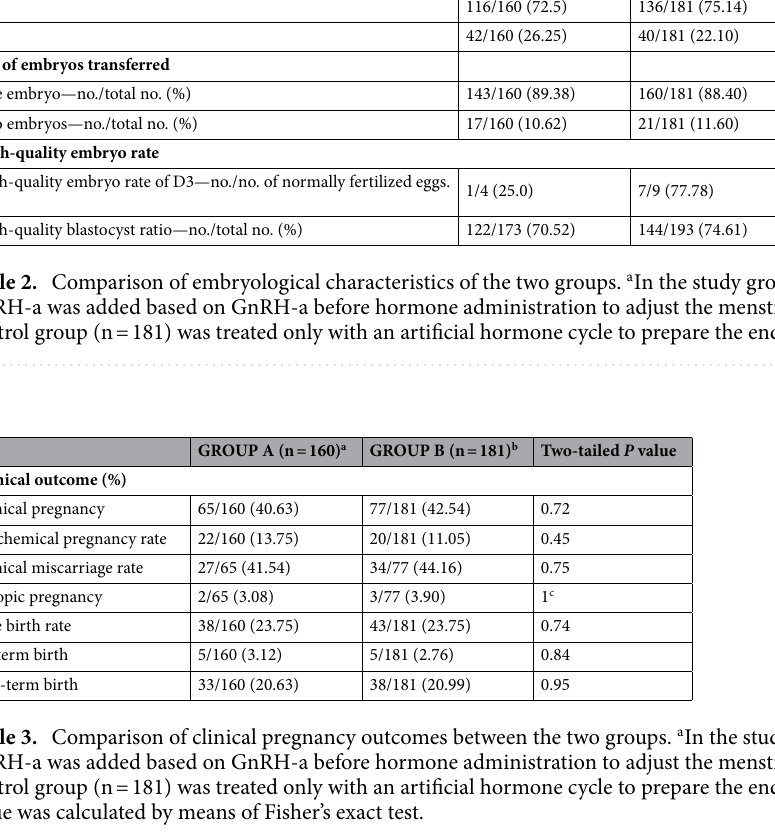
time of embryo transfer and the number of transferred embryos did not differ obviously between the two groups. The percentages of day-3, day-5 and day-6 embryo transfers and the percentages of one- and two-embryo in the two groups were not significantly different (1.25% vs. 2.76%, 72.5% vs. 75.14%, 26.25% vs. 22.10%, P = 0.44; 89.83% vs. 88.40%, 10.62% vs. 11.60%, P = 0.78). High-quality embryos of D3 were generally defined as embryos derived from normal fertilized eggs, and the number of embryonic cells on the third day after fertilization was 7–9, the cell size was in line with the developmental stage, the degree of fragmentation was less than 10%, and the embryo was not multinucleated. High-quality blastocysts were generally defined as blastocysts of stage 3 and above in the Gardner scoring standard, and the inner cell mass and trophoblast scores did not contain C. There was no significant difference in high-quality embryo rate of D3 and high-quality blastocyst ratio between the two groups (25.00% vs. 77.78%, P = 0.22; 70.52% vs. 74.61%, P = 0.38). Considering some participants may undergo a fresh embryo transfer before FET, the number of these patients were compared and the difference was not statistically significant, (53.13% vs. 52.49%, P = 0.91). At the same time, we analysised the reproductive outcomes of the fresh embryo transfer between the two groups. The GnRH-a downregulation group in clinical pregnancy rates, biochemical pregnancy rates, ectopic pregnancy rates, clinical miscarriage rates and live birth rates did not show any significant difference compared to the hormone replace- ment cycle group (30.59% vs. 24.21%, P = 0.34; 8.24% vs. 7.37%, P = 0.83; 73.08% vs. 56.52%, P = 0.23; 3.85% vs. 8.70%, P = 0.91; 8.24% vs. 10.53%, P = 0.60). As shown in Table 3, we compared the pregnancy outcomes of the infertility patients with adenomyosis in the two groups. Among both groups, the clinical pregnancy rates (40.63% vs. 42.54%, P = 0.72) and the live birth rates (23.75% vs. 23.75%, P = 0.74) were not different, and the clinical miscarriage rates (41.5% vs. 44.2%, P = 0.754), biochemical pregnancy rates (13.75% vs. 11.05%, P = 0.45) and ectopic pregnancy rates (3.08% vs. 3.90%, P = 1) were similar. Binary logistic regression, shown in Table 4, revealed that BMI, endometrial thickness on the HCG trigger day or No. of high-quality embryos were not related to clinical pregnancy rates. However, it was the age and the embryo stage at transfer (OR 0.42, 95% CI 0.19 to 0.93 for patients patients from 31 to 35 years old compared with patients no more than 30 years old; OR 0.61, 95% CI 0.30 to 1.26 for patients from 36 to 40 years old compared with patients no more than 30 years old; OR 0.70, 95% CI 0.33 to 1.48 for patients from 41 to 45 years old com- pared with patients no more than 30 years old; OR 0.38, 95% CI 0.76 to 1.96 for women having a day-5 embryo transfer compared with women having a day-3 embryo transfer; OR 0.37, 95% CI 0.20 to 0.68 for women having